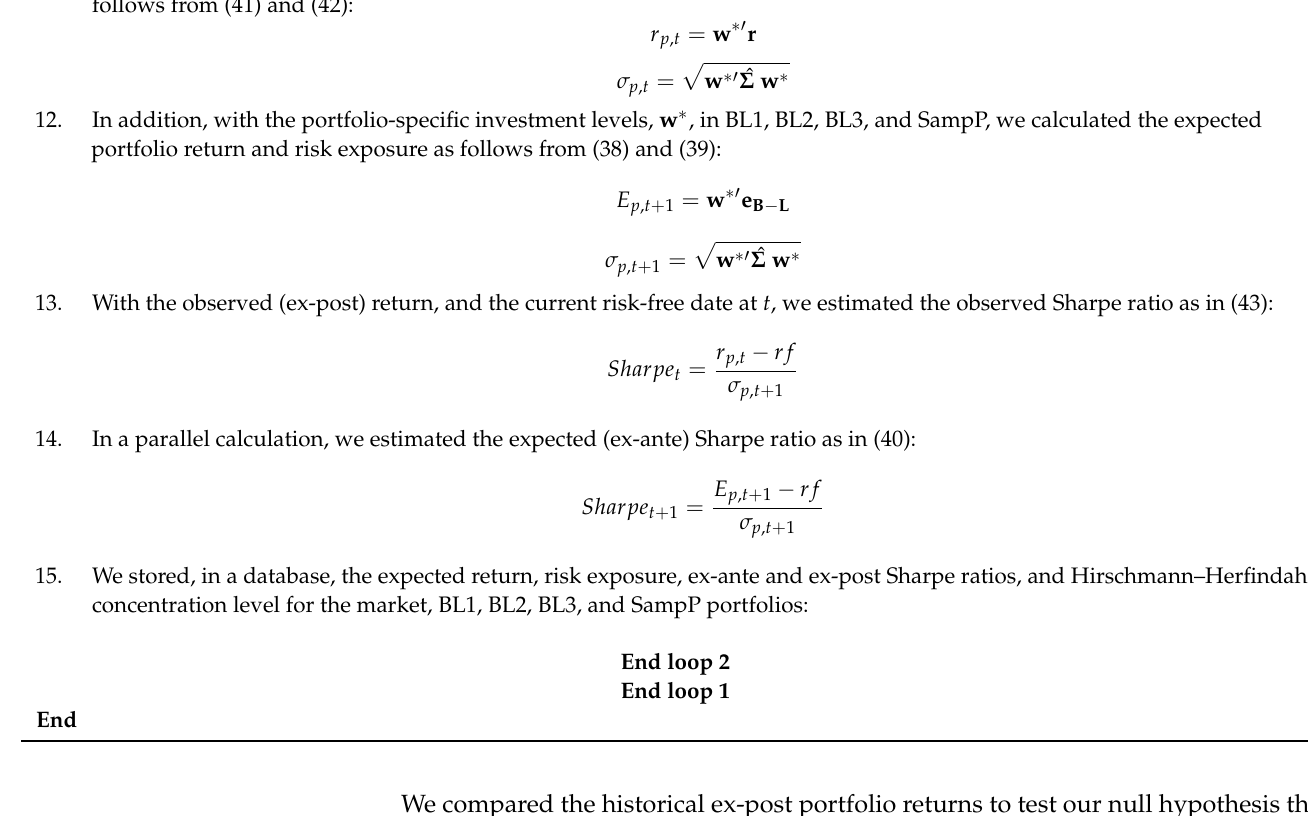
Algorithm 1: The steps followed in the portfolio simulation of BL1, BL2, BL3, and SampP.